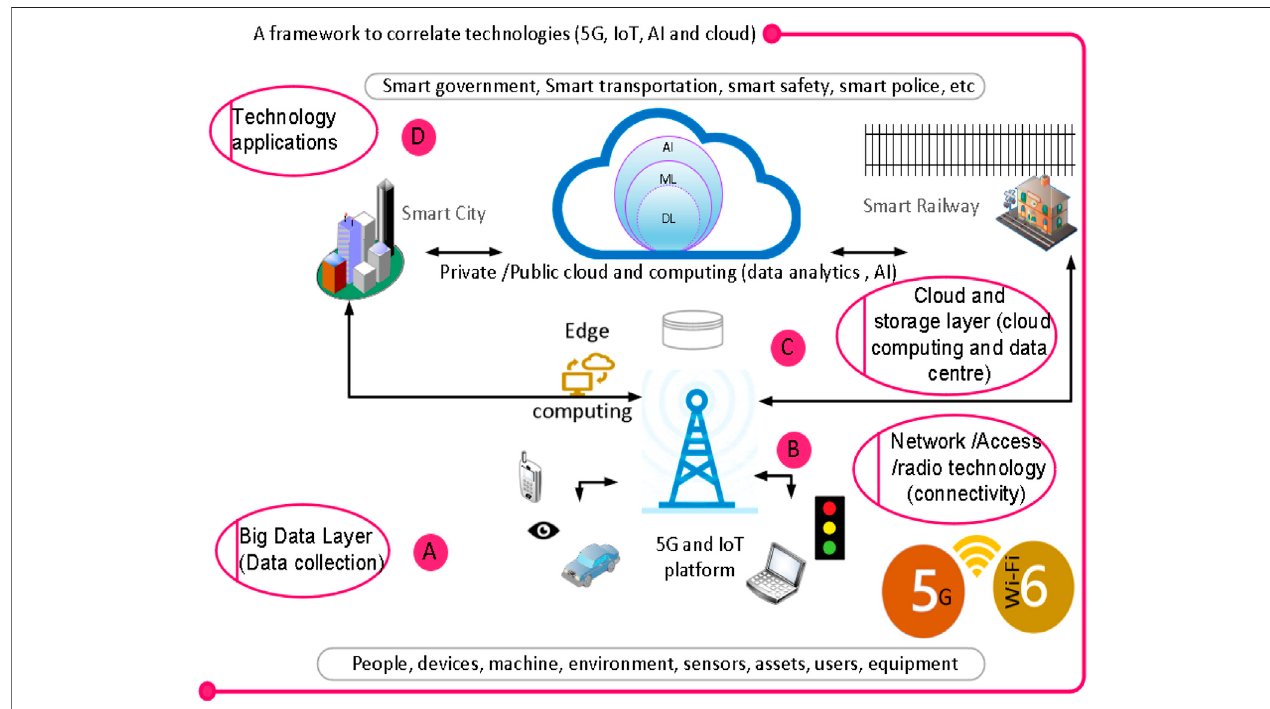
FIGURE 1 | Illustration of how the smart systems integrate the cloud, 5G, and IoT into the outlined health, safety, and security framework of the railway system.